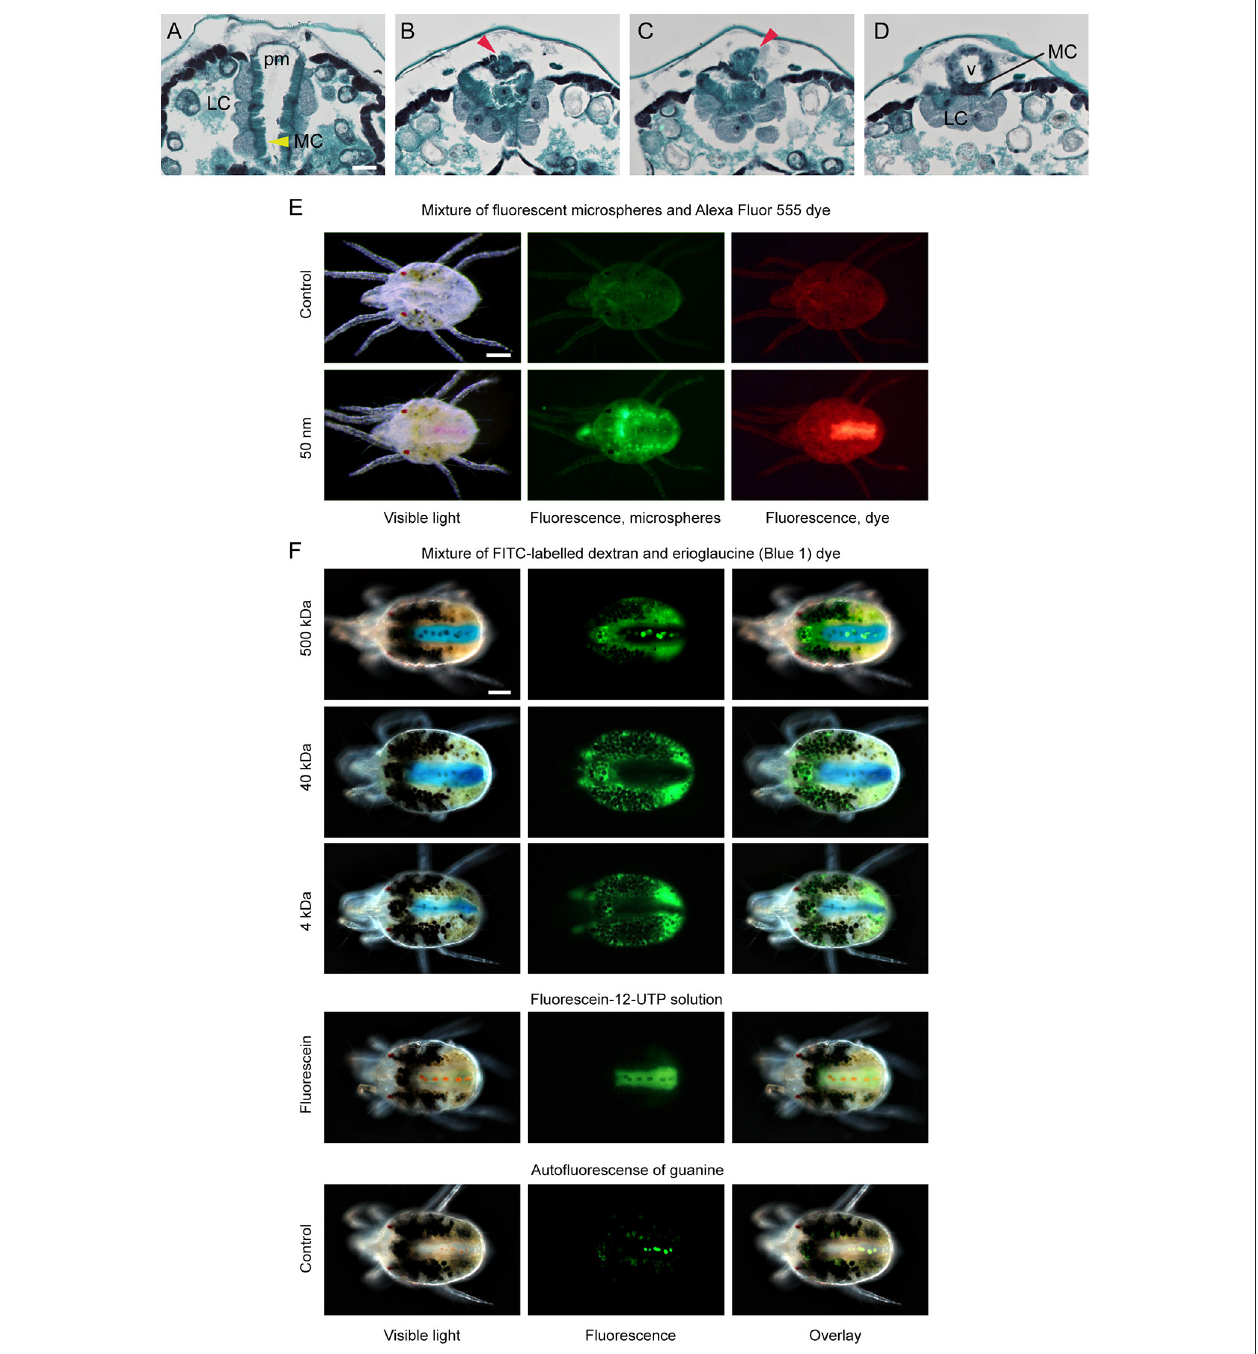
FIGURE 6 | Permeability of ventriculus-posterior midgut barrier in spider mites. (A–D) Serial transverse sections of the dorsal region of spider mite body in the area of connection between ventriculus (v) and posterior midgut (pm). (A) Typical arrangement of V-shaped posterior midgut positioned between two caudal caeca. LC, large cells of caudal caeca epithelium adjacent to posterior midgut (pm); MC, microvilli cells of posterior midgut (yellow arrowhead). (B,C) Anteriorward sections through the posterior midgut that narrows, while the posterior-dorsal portion of the ventriculus appears (red arrowhead). (D) Section through the point of ventriculus-posterior midgut connection. (E) Distribution of the 50nm fluorescent microspheres and fluorescent dye Alexa Fluor 555 (1250 Da) in mite midgut upon the ingestion of their mixture. Alexa Fluor 555 readily passes through midgut and accumulates within posterior midgut, while 50nm microspheres are retained in the caeca lumen. (F) Distribution of the FITC-labeled dextrans of different sizes and erioglaucine dye in mite midgut upon the ingestion of their mixture. Erioglaucine (793 Da) and fluorescein-12-UTP (1034 Da) accumulate in posterior midgut while FITC-labeled dextrans (4, 40, and 500 kDa) are retained in the caeca lumen. Guanine autofluorescence can be seen within digestive cells in midgut and in pellets in the posterior midgut. Scale bars: (A–D) : 25 µ m; (E,F) : 100 µ m.